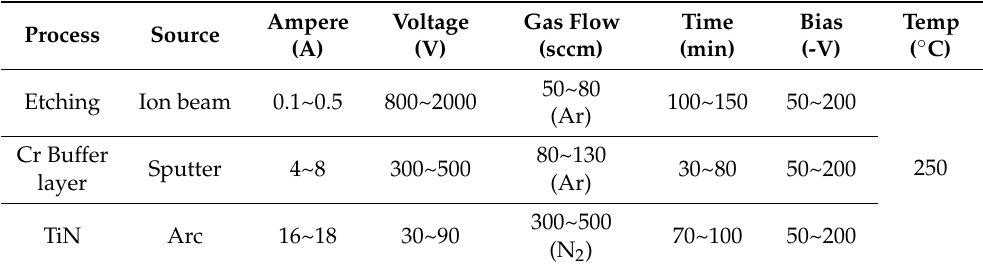
Table 2. Deposition conditions of TiN coating with